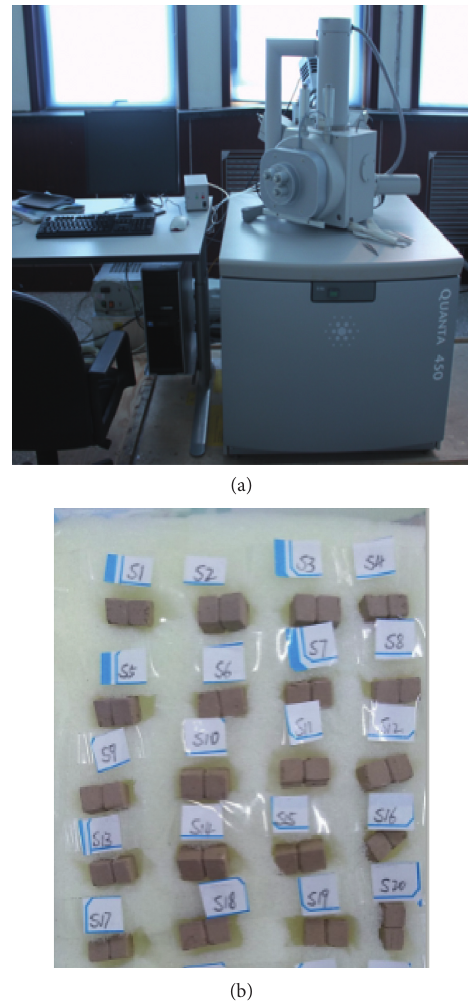
Figure 5: Scanning electron microscope and samples.